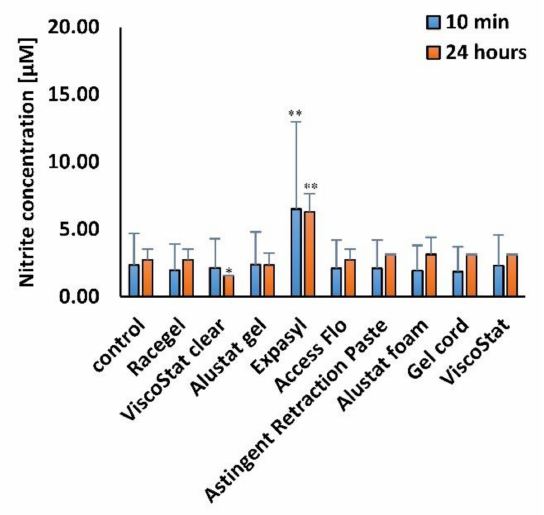
Figure 4. The oxidative stress detected by nitrite (NO 2 − ) concentration assay in human gingival fibroblasts after various time points of incubation (10 min and 24 h), with the gingival retraction agents diluted in the cell culture medium to 1 mg/mL concentration; * p < 0.05, ** p < 0.005.